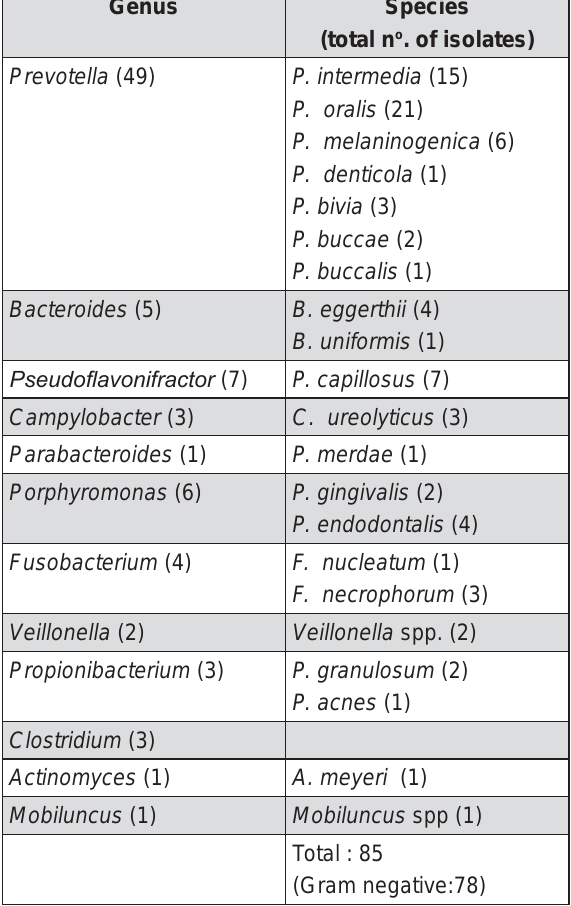
Figure 1- Table 1- The prevalence of cfxA (cid:3)(cid:74)(cid:72)(cid:81)(cid:72)(cid:86)(cid:3)(cid:76)(cid:81)(cid:3)(cid:87)(cid:75)(cid:72)(cid:3)(cid:533)(cid:16)(cid:79)(cid:68)(cid:70)(cid:87)(cid:68)(cid:80)(cid:68)(cid:86)(cid:72)(cid:16)(cid:83)(cid:85)(cid:82)(cid:71)(cid:88)(cid:70)(cid:76)(cid:81)(cid:74)(cid:3)(cid:82)(cid:85)(cid:68)(cid:79)(cid:3)(cid:68)(cid:81)(cid:68)(cid:72)(cid:85)(cid:82)(cid:69)(cid:76)(cid:70)(cid:3)(cid:69)(cid:68)(cid:70)(cid:87)(cid:72)(cid:85)(cid:76)(cid:68)